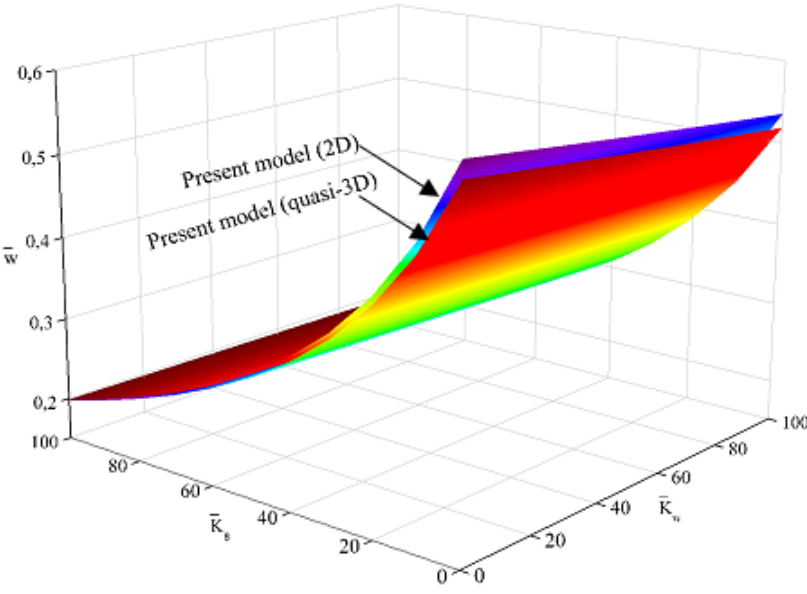
(cid:0) (cid:1) K w , K s on the non-dimensional deflection w of FG square ( ) on the non-dimensional deflection w of FG sw KK , (